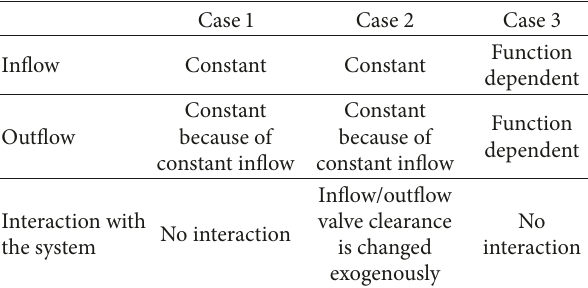
Table 2: Differences between